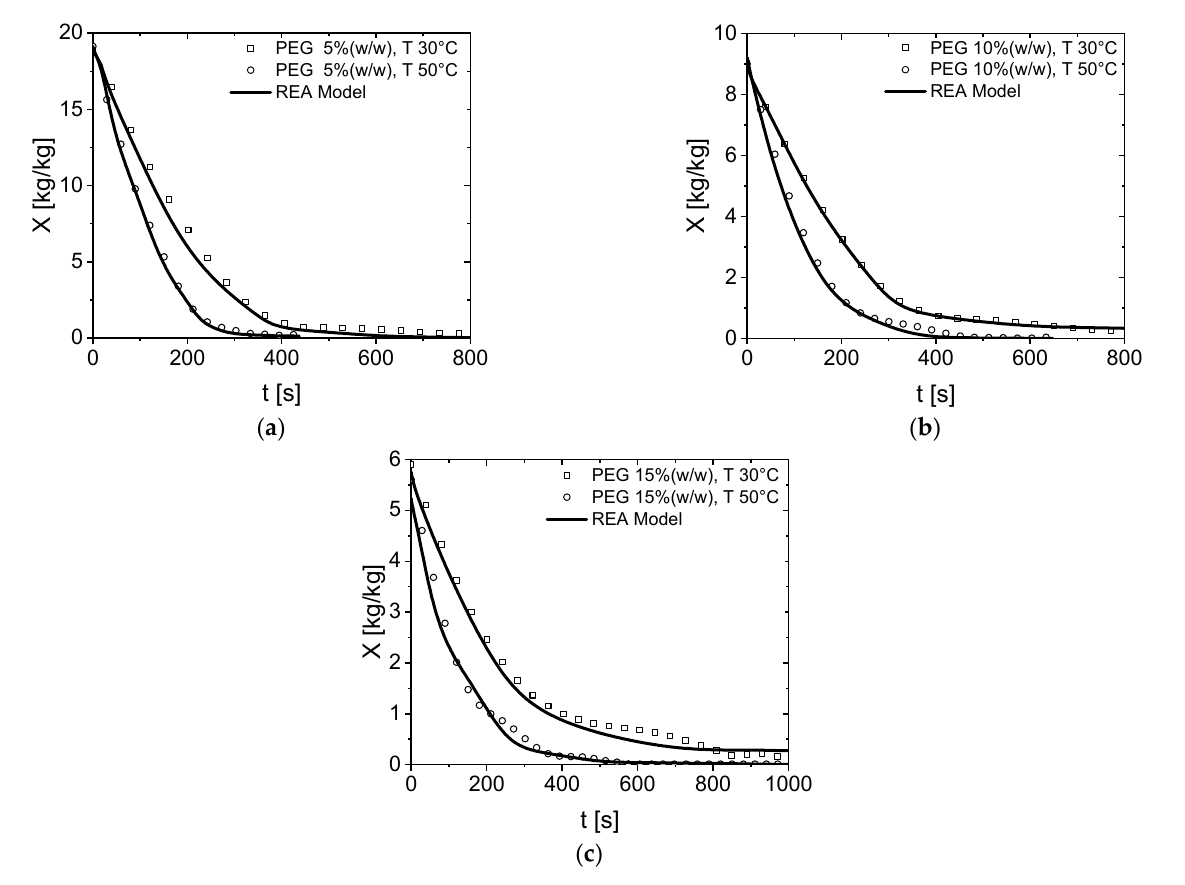
Figure 6. The drying curves of PEG600 in terms of dry mass content ( X ) versus time, and the corresponding REA model (solid lines). The initial polymer mass fractions are ( a ) 5%, ( b ) 10%, and ( c ) 15% ( w / w ). The temperature of the drying gas is 30 °C and 50 °C.